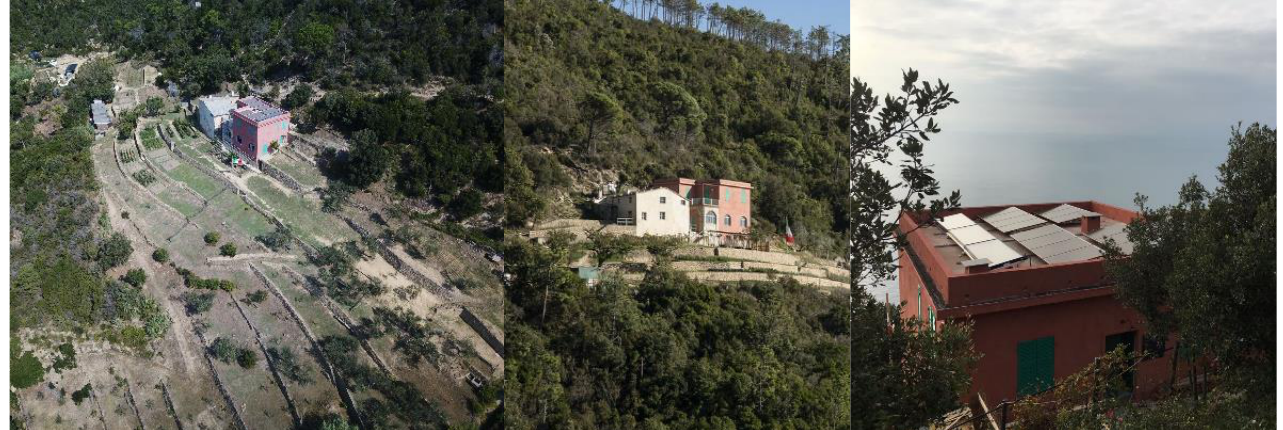
Figure 10. Positive example of the “ concealment ” of the solar intervention in the Podere Case Lovara in Levanto (Italy) thanks to the presence of traditional PV and ST panels hidden behind a parapet and not visible from the protected landscape of the Cinque Terre Natural Park (Source: Fondo per l’Ambiente Italiano ).